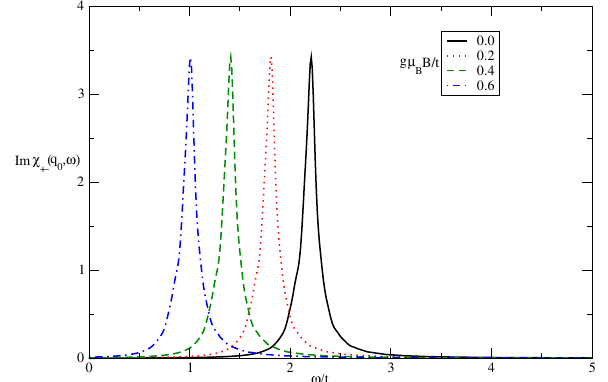
( q 0 , ω) of undoped +− 0.05 . B T / t =